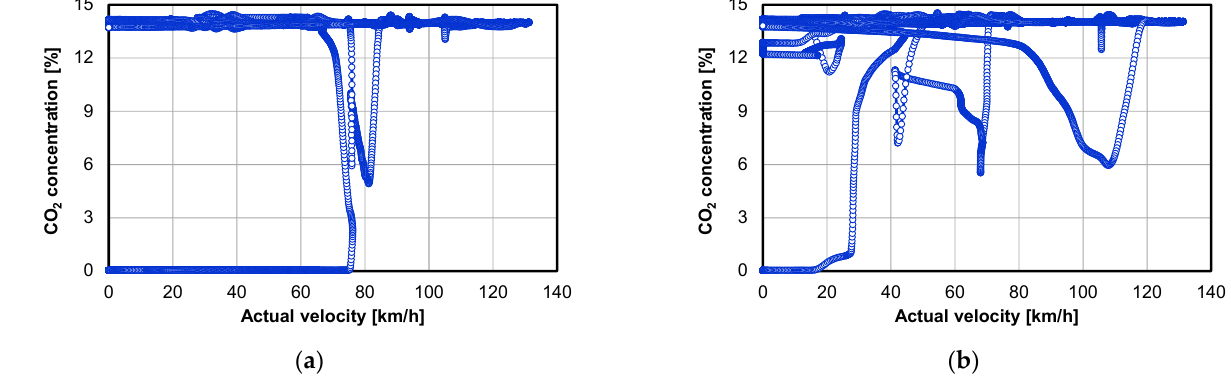
Figure 10. The CO 2 concentration versus actual velocity for: ( a ) plug-in; ( b ) HEV.